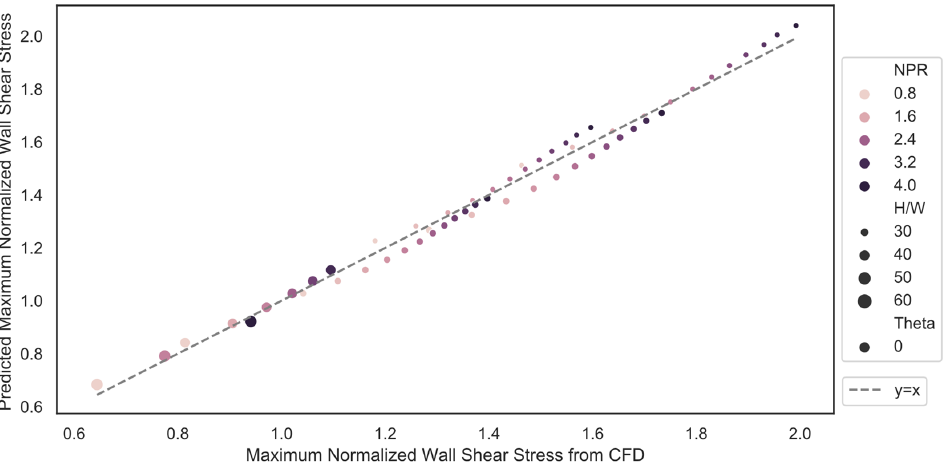
Figure 5. Predicted maximum normalized wall shear stress plotted against maximum normalized wall shear stress from CFD for normal impingement. Shade represents the nozzle pressure ratio, whereas the symbol represents the height-to-width ratio.